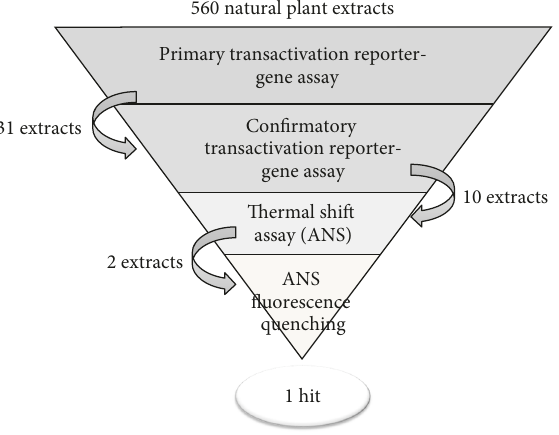
Figure 7: Screening pipeline for PPARß/ 𝛿 agonists. Our proposed screening pipeline for PPARß/ 𝛿 agonists is composed of 3 com- plementary assays. The primary transactivation reporter-gene assay screening and the confirmatory transactivation reporter-gene assay utilize a cellular transactivation reporter-gene assay that has been optimized to a 3-day long experiment with 40,000 cells and only 25 𝜇 L of the luciferases substrates per well, reducing the time and cost of the screening assay. The two following validation assays are the thermal shift (TSA) to check if the compounds/extracts previously selected stabilize the PPARß/ 𝛿 tertiary structure and the ANS fluorescence quenching to determine the compound affinity to the hydrophobic pocket of PPARß/ 𝛿 . We submitted a 560-natural extract library to the proposed pipeline and found 31 possible hit candidates in the primary transactivation screening. Ten hit can- didates were selected in the confirmatory cellular transactivation. The TSA selected 2 extracts, and one of them showed a 0.02 mg/mL affinity constant in the ANS quenching